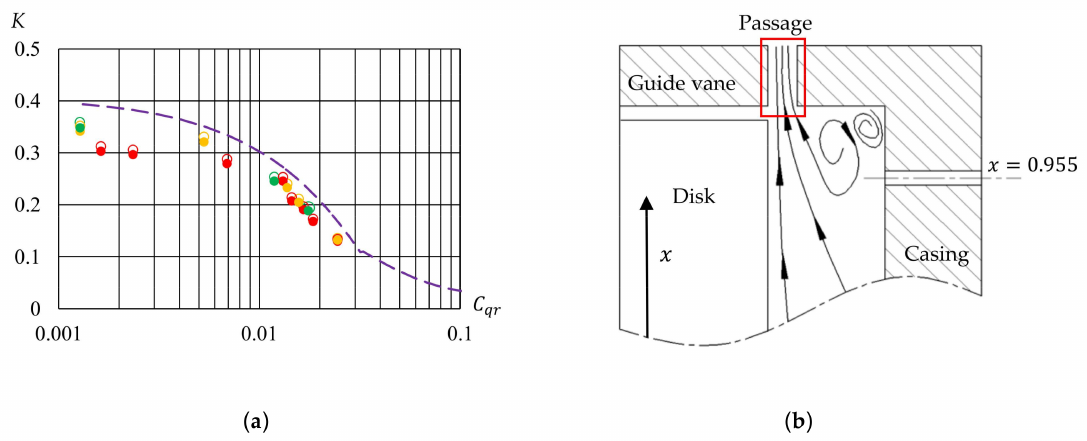
Figure 10. Large differences of K attributed to the geometry near the outlet: ( a ) Part of the results do not fit Equation (11) and ( b ) Surface streamlines near the outlet (from numerical simulation). C qr : local flow rate coefficient; K : core swirl ratio; x : non-dimensional radial